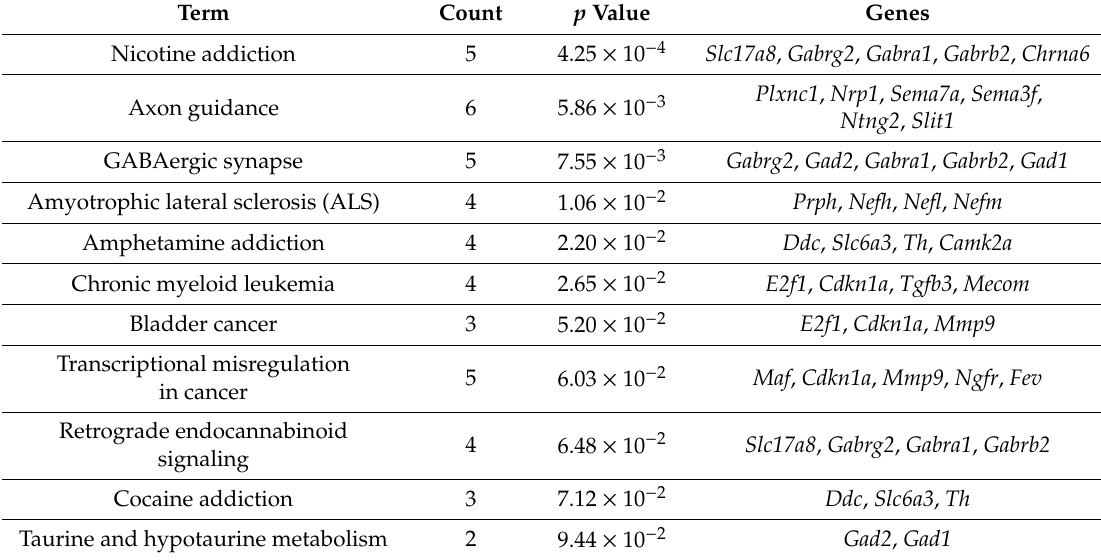
Table 3. Metabolic pathways most significantly altered in defeated mice compared to